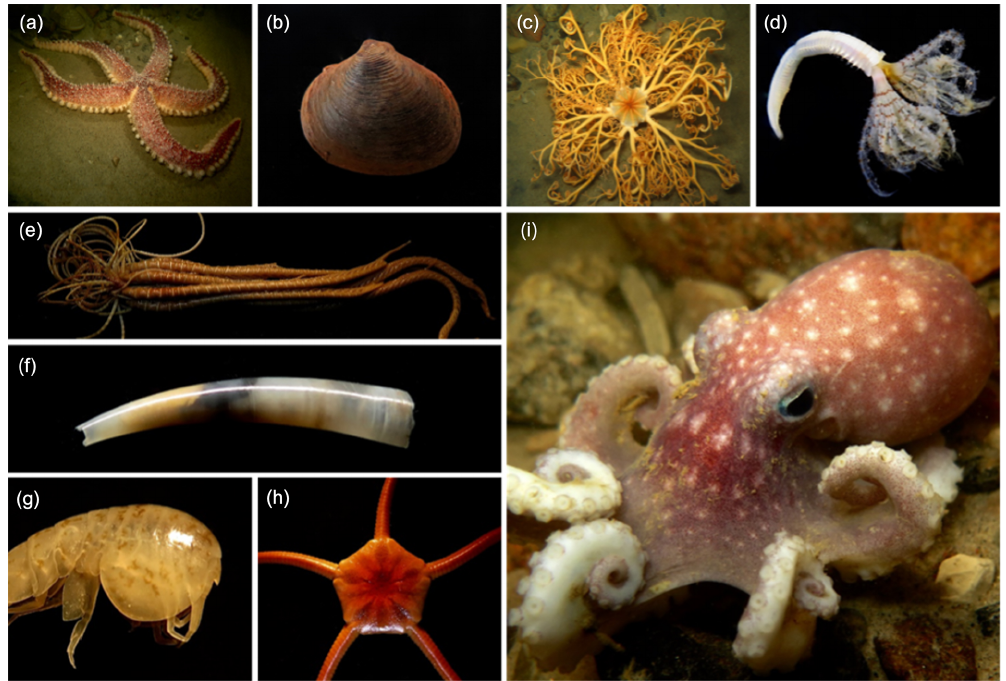
Figure 14. Examples of benthic organisms. (a) Urasterias lincki , (b) Astarte borealis , (c) Gorgonocephalus eucnemis , (e) Brachiomma sp., (f) Heliometra glacialis , (g) Siphonodentalium lobatum , (h) Stegocephalus inflatus , (i) Ophiopleura borealis , Bathypolypus sp. (pictures by Benthic Ecology Lab, Université Laval, Gonzalo